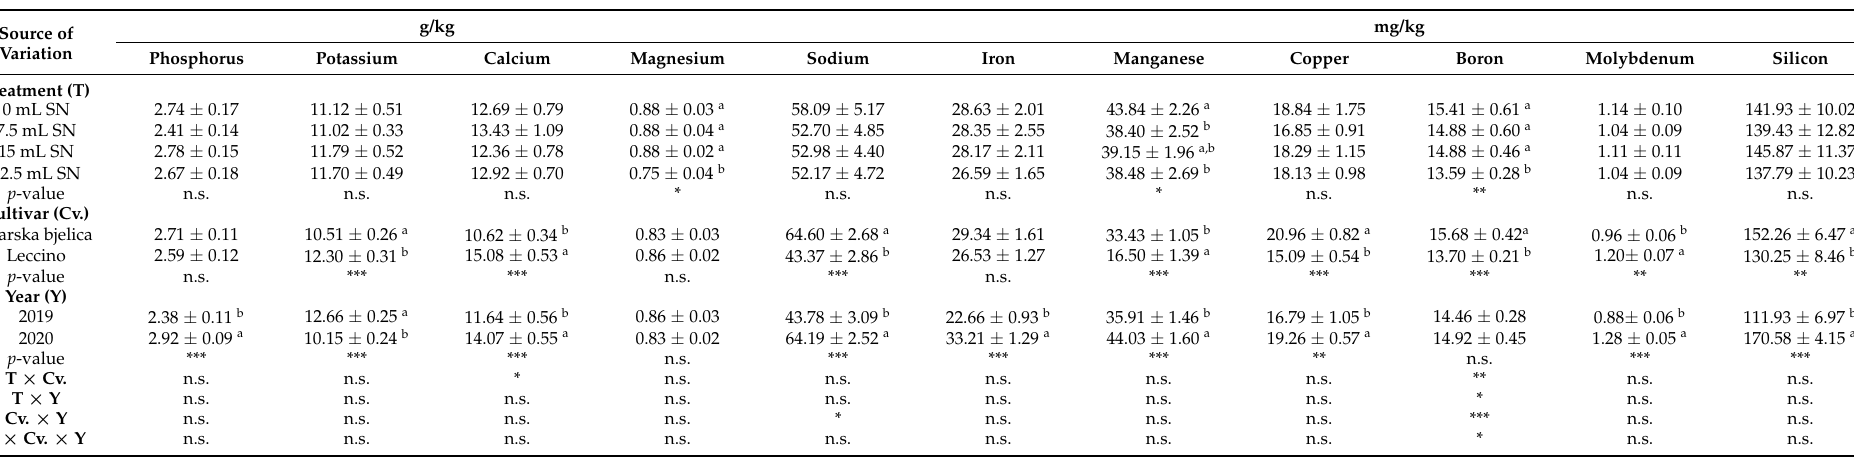
Table 1. The effect of treatment (T) (0, 7.5, 15, and 22.5 mL of applied SN foliar fertilizer per 1 L of water), cultivar (cv.) (Istarska bjelica, Leccino), and collection year (Y) (2019, 2020) on the concentrations of macro- and micro-elements in olive